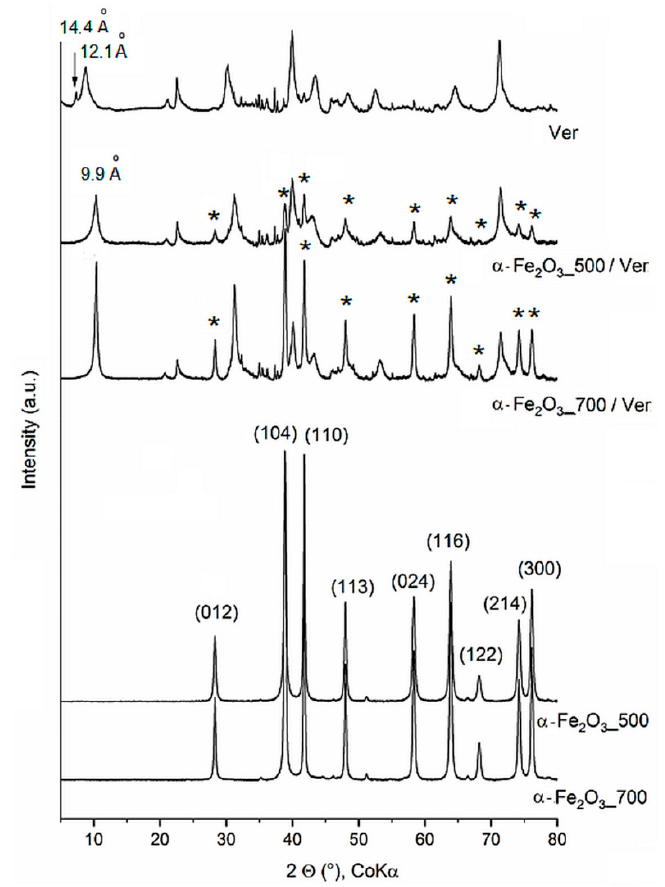
Figure 1. XRD patterns of α -Fe 2 O 3 and α -Fe 2 O 3 /Ver samples calcined at 500 °C and 700 °C (peaks of α -Fe 2 O 3 are marked by asterisk). Table 1. α -Fe 2 O 3 nanoparticles: the mean coherent crystallite size and lattice parameters.